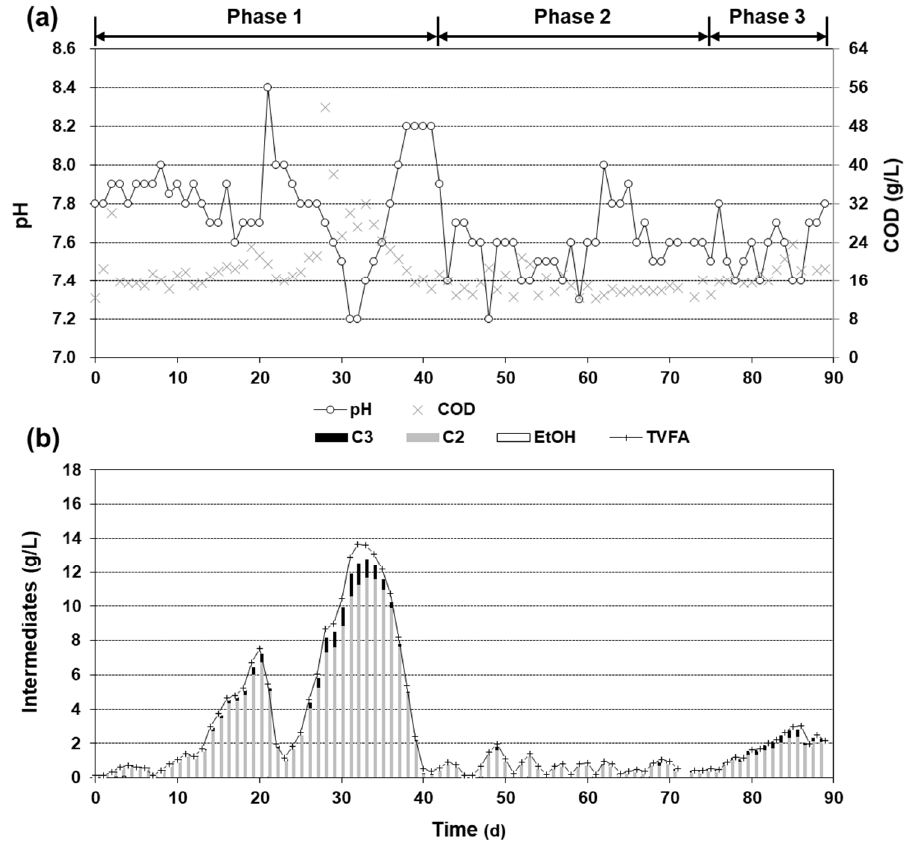
Figure 4. Profiles of ( a ) pH, COD, and ( b ) intermediates during the operation. TVFA here indicates the sum of VFAs (C 2 to C 6 ) and ethanol (EtOH).